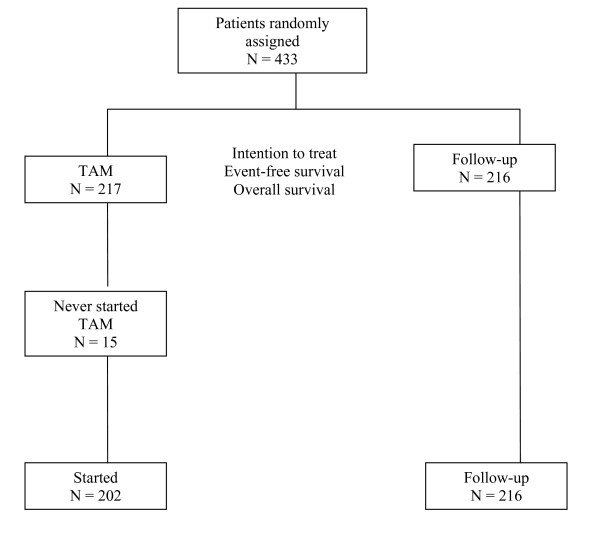
Consort Diagram.